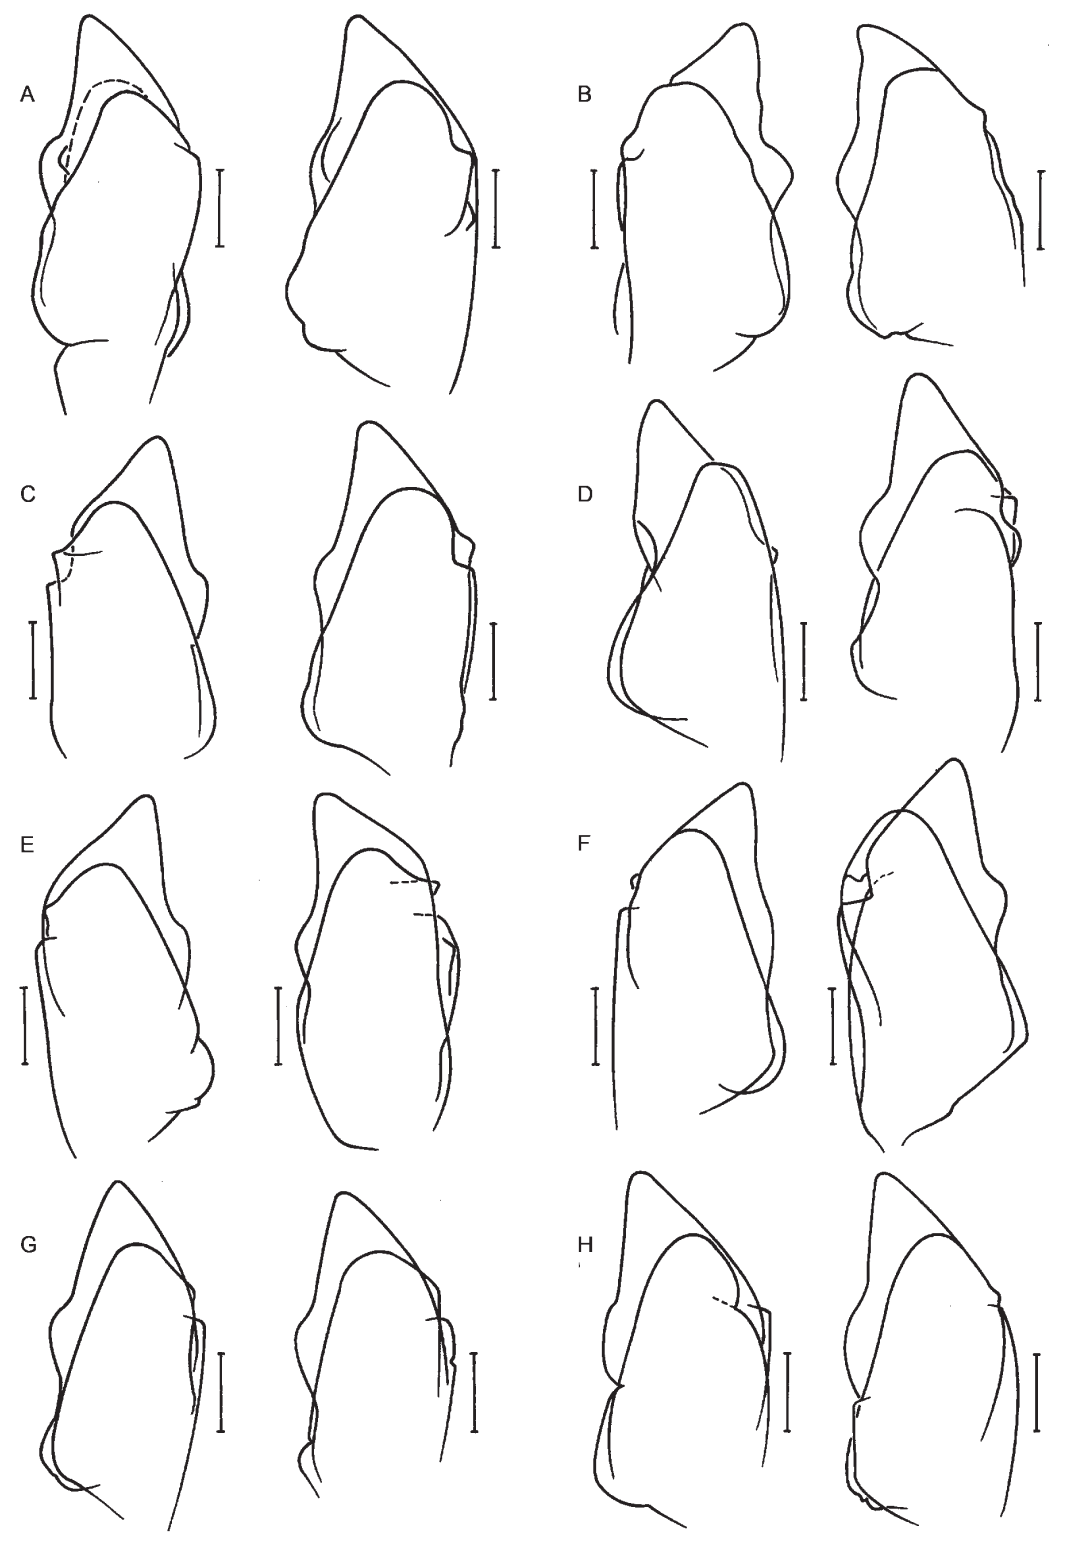
Fig. 13. Candobrasilopsis brasiliensis (Sars, 1901) comb. nov., hemipenis. A . MZUSP.28117. B . OC.3295. C . OC.3296. D . MZUSP.28120. E . MZUSP.28121. F . MZUSP.28122. G . MZUSP.28123. H . MZUSP.28124. Scale bars: A-F = 50